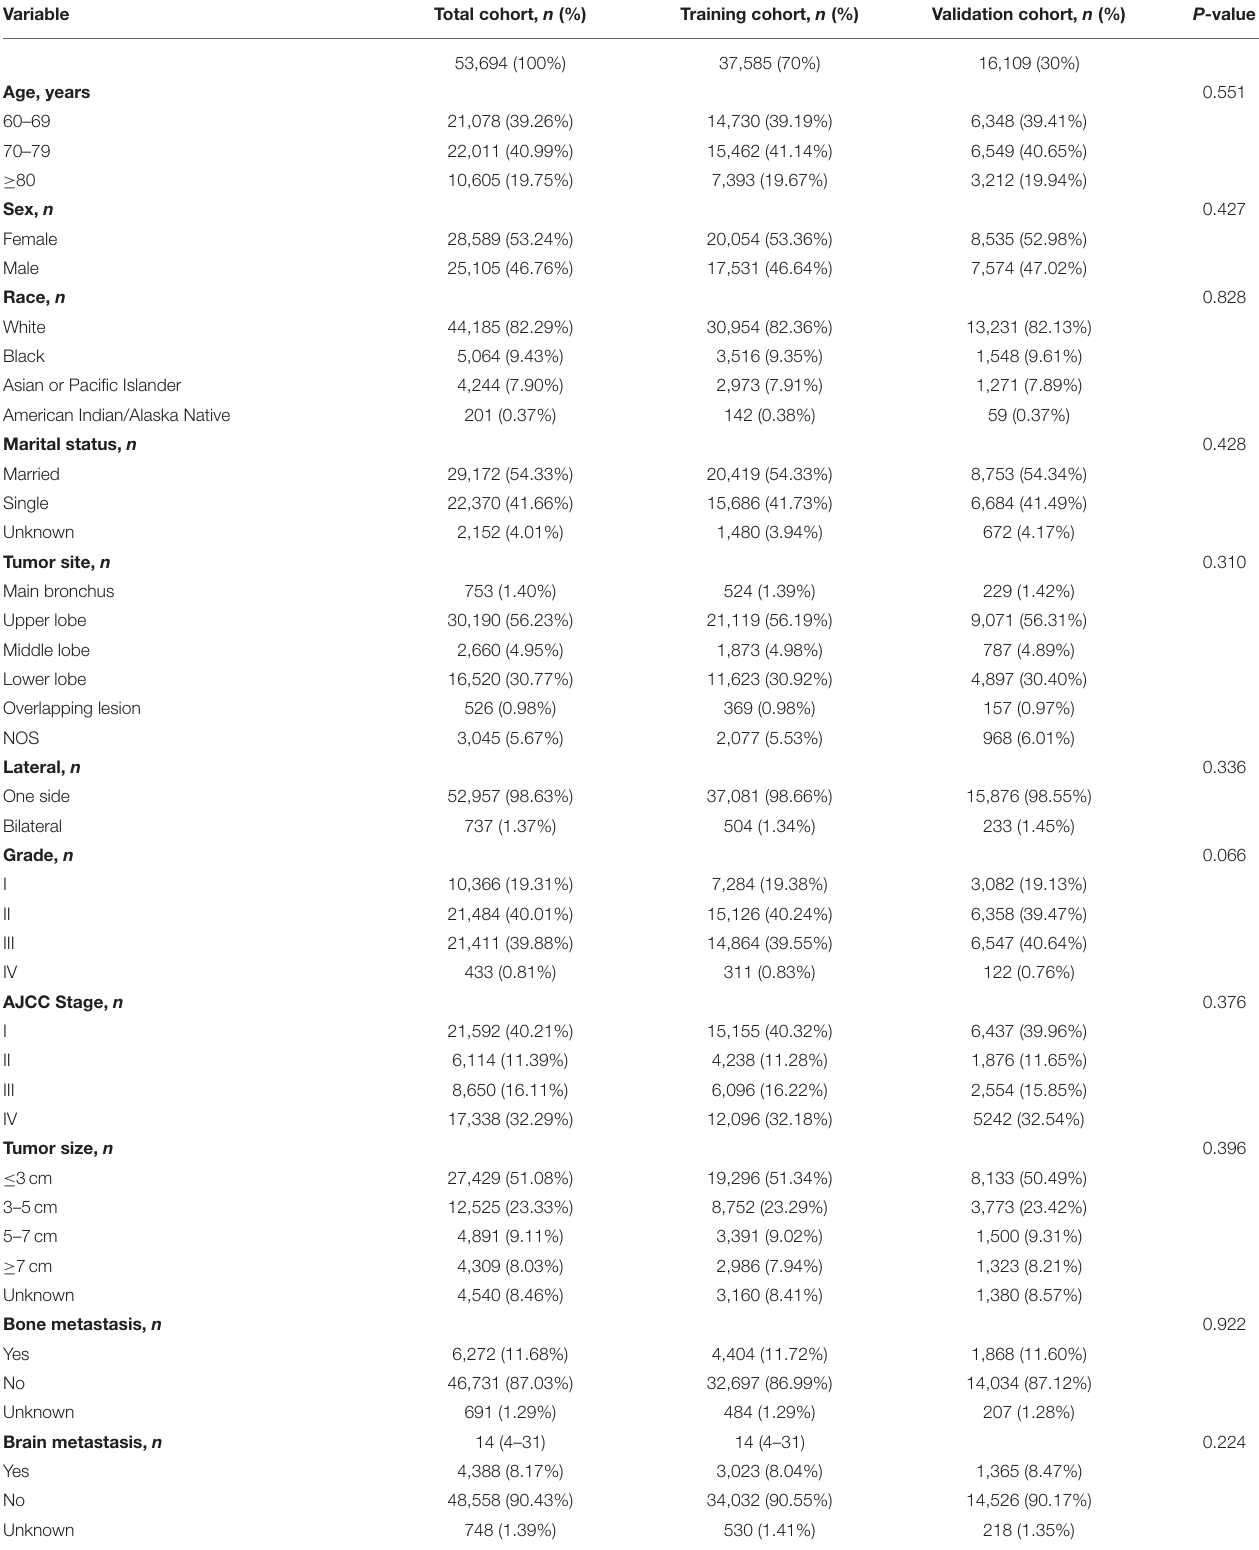
TABLE 1 | Patients’ demographics and clinicopathological